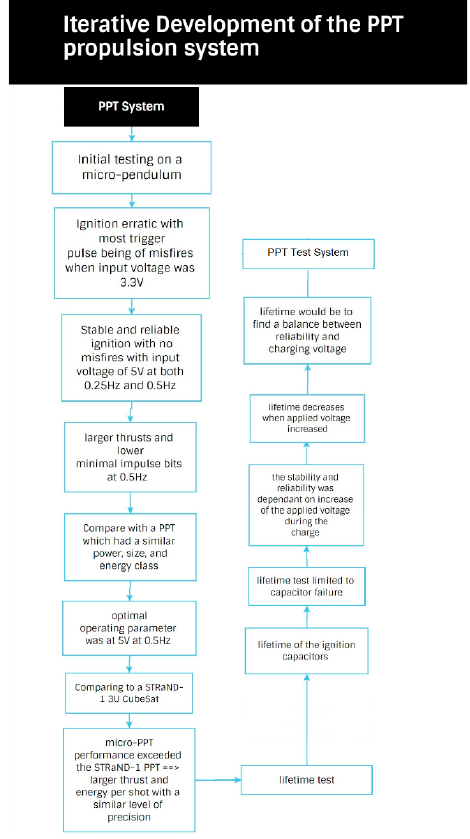
Figure 12. Summary of the iterative design process.